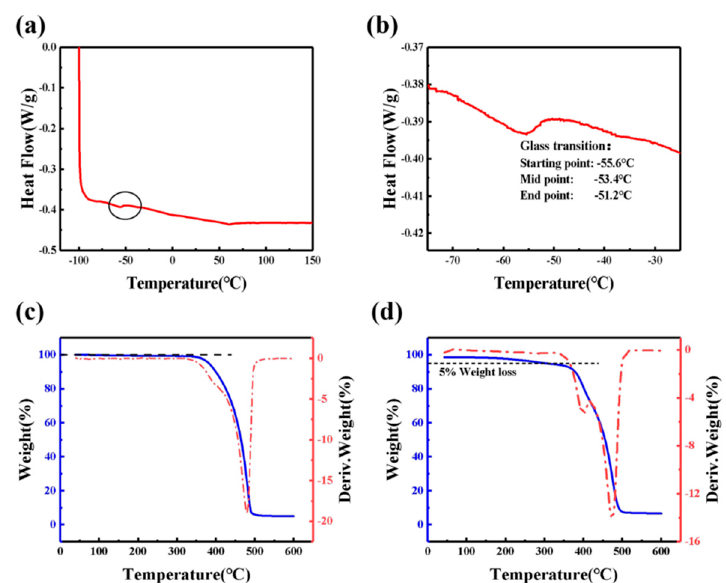
Figure 3. ( a ) Differential scanning calorimetry (DSC) thermograms for GPE-ILs over the temperature range from − 100 to 150 ◦ C at a heating rate of 10 ◦ C min − 1 . ( b ) Enlarged view of area for glass transition. TGA and its DTG curve of ( c ) [Emim]TFSI and ( d ) GPE-ILs.